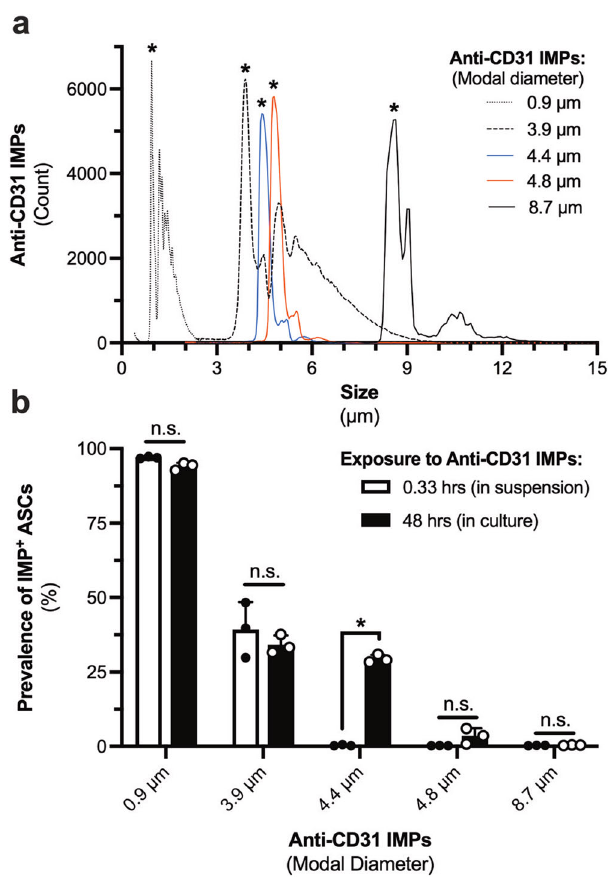
Fig. 8 Size affects the extent and temporal dynamics underlying the uptake of immunomagnetic microparticles (IMPs) by adipose tissue- derived stromal/stem cells (ASCs). a Size distribution of fi ve distinct anti- CD31 IMPs. * p < 0.05 compared with all other IMPs. b Total uptake (i.e. membrane-bound and/or internalized) of the different anti-CD31 IMPs by ASCs after 20 min in suspension (i.e. labelling conditions for magnet- assisted cell sorting) and 48 hr in culture. Values represent mean ± standard deviation; * p < 0.05; and, ns represents not signi fi cant. This experiment was performed in biological triplicate, using cells derived from three different donors ( n = 3 biologically independent